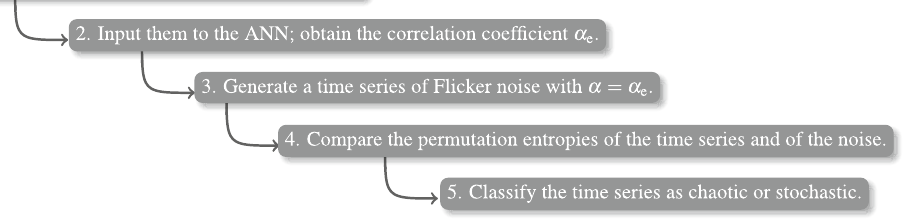
Figure 2. Schematic representation of the methodology. We compute the probabilities of the ordinal patterns and then use them as input features to the ANN. The ANN returns the temporal correlation coefficient α e . Then we compare the permutation entropy of the analyzed time series with the permutation entropy of a FN time series generated with the same α e value. Based on this comparison, we use Eq. (1) to classify the time series as chaotic or stochastic.